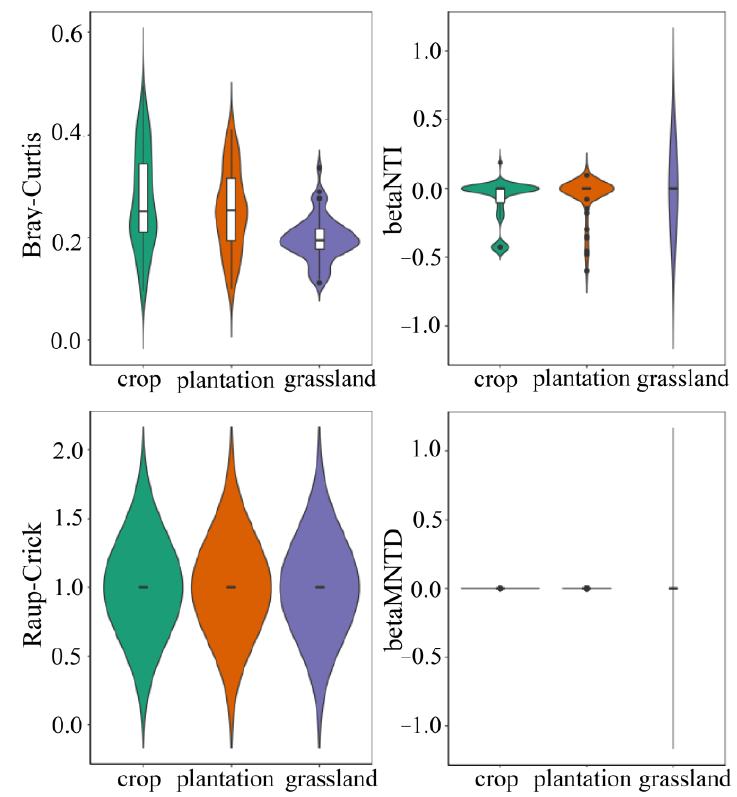
Figure 10. Null model of soil bacterial community in three karst land-use types.